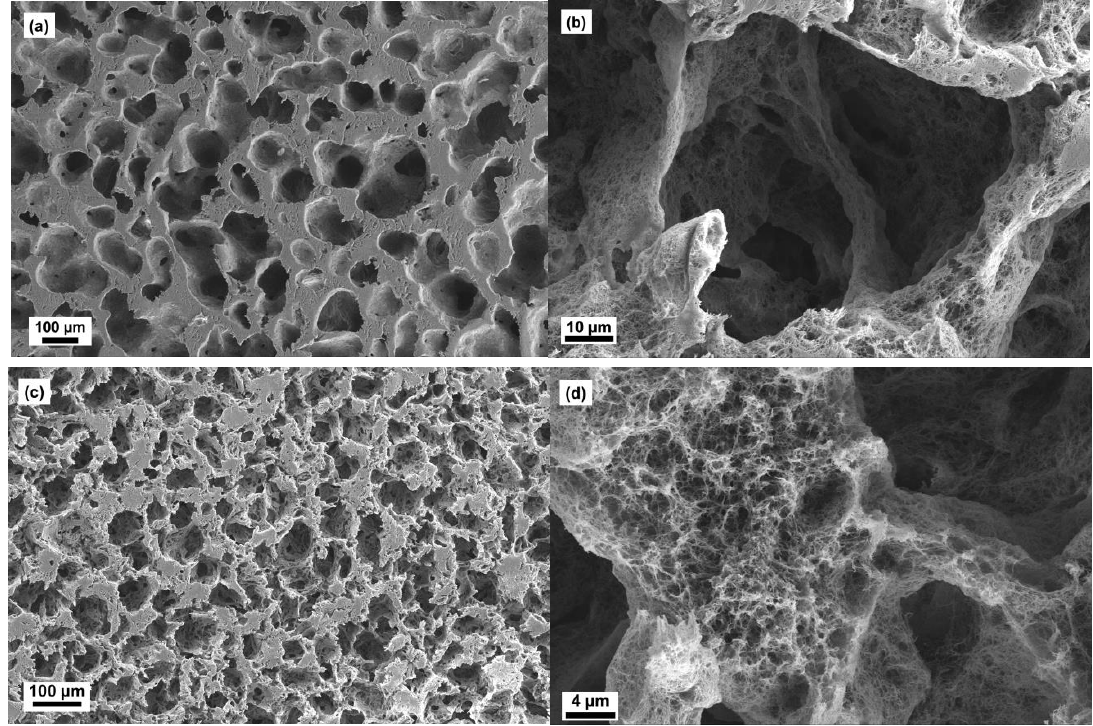
Figure 3. Scanning electron microscopic images of ACS-PS15 ( a,b ) and ACS-PC16 ( c,d ).